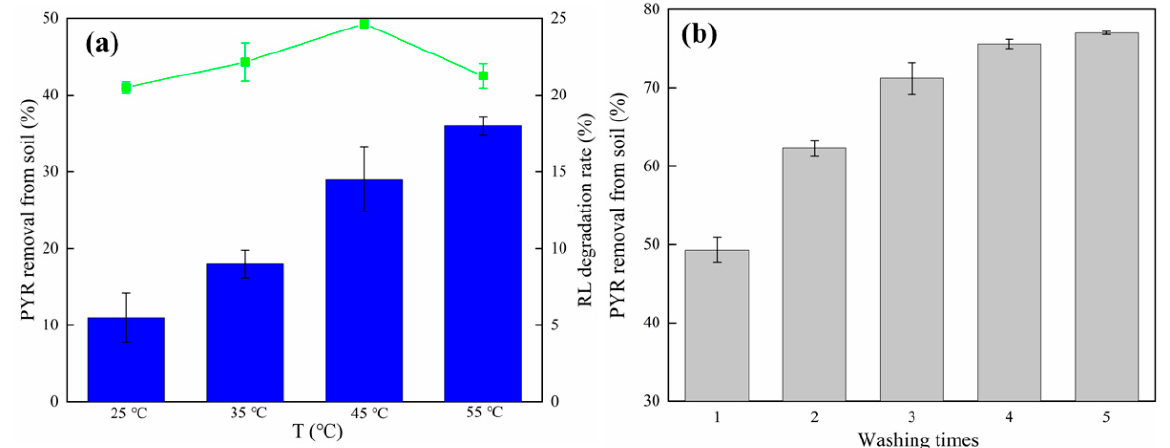
Figure 2 . Effect of ( a ) temperature and ( b ) washing times on the elution rate of pyrene. Experimental conditions: [RL] = 20 g/L; [oscillation time] = 24 h; 25 °C, 160 rpm; no pH adjustment. RL, rhamnolipids.